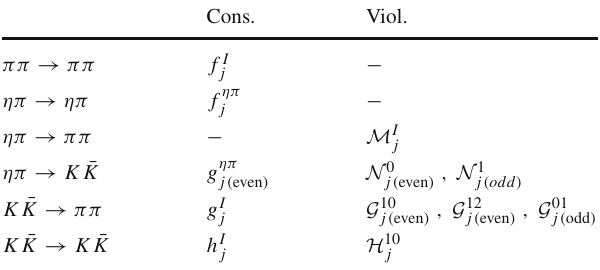
Table1 Isospin-conserving(cons.)andisospin-violating(viol.)ampli- tudes involving ππ , πη and K ¯ K channels Cons.